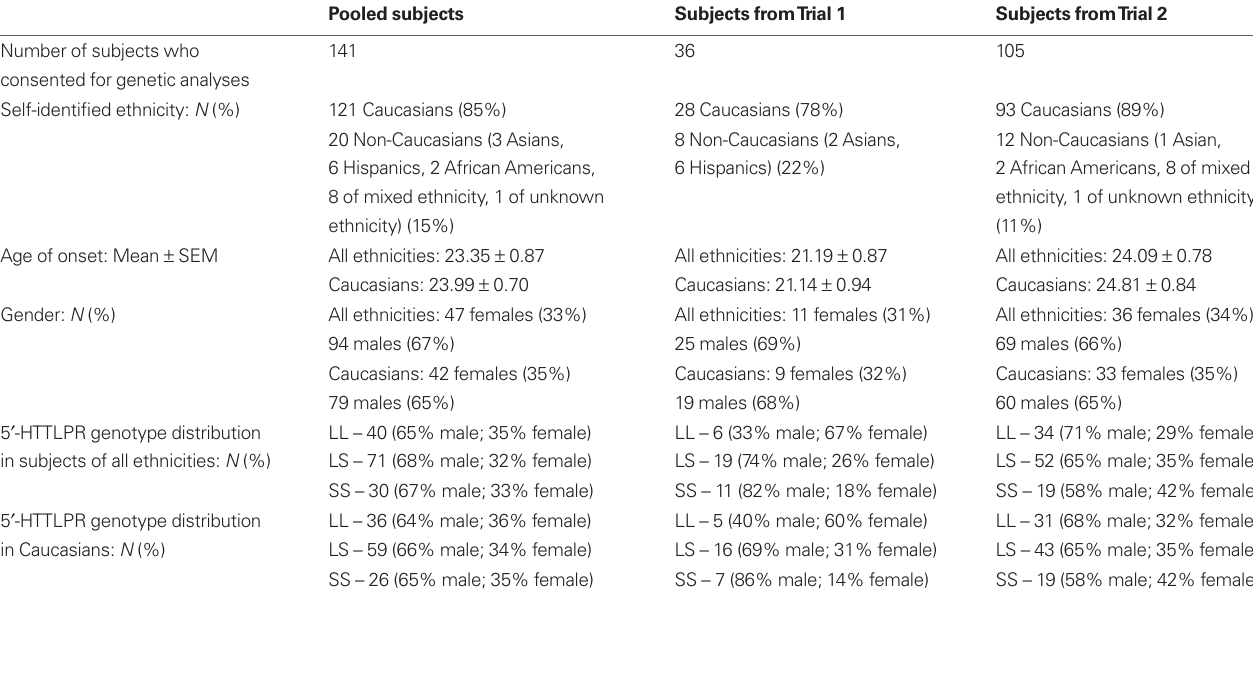
Table 1 | Demographic information on the subjects included in the study.